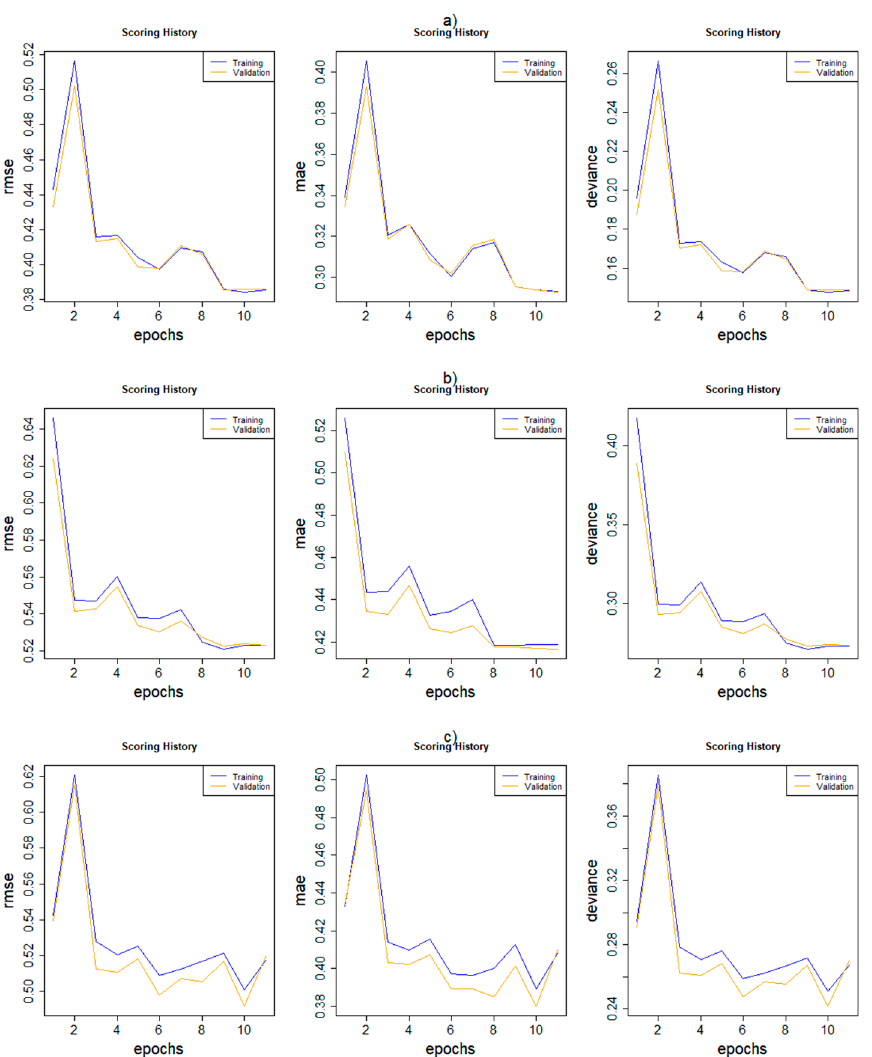
Figure 4. Model accuracy for each iteration during model calibration in three phenology stages: ( a ) SOS, ( b ) LOS, and ( c ) EOS. Table 4. Scoring performance of DFNN model at each iteration during the different phenological stage. Samples Epoch